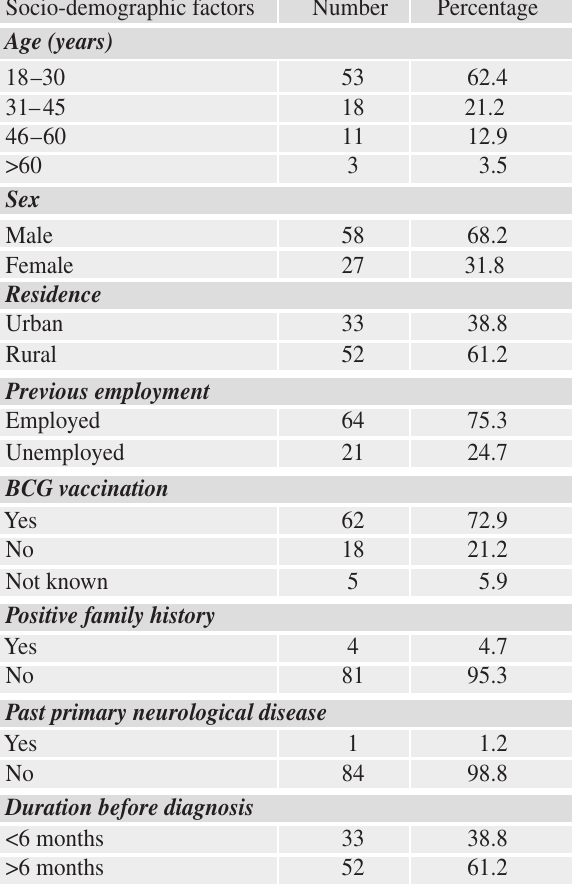
Table I: Distribution of leprosy patients according to socio-demographic factors (N=85)!